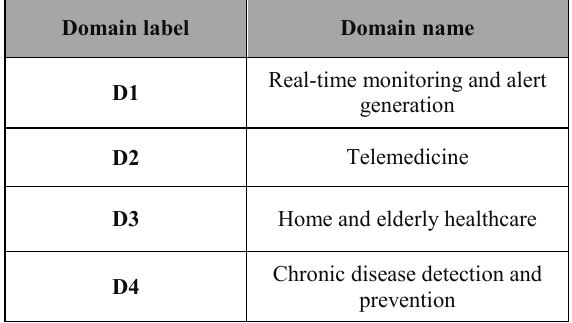
Table 1. Labelling of the four healthcare domains used for our gravity evaluation